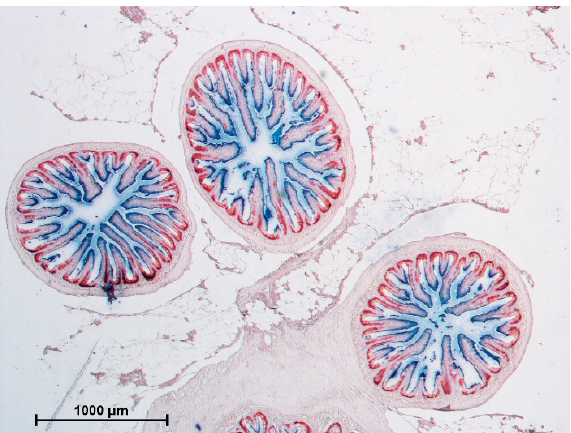
Figure 15. Representative figure of PCNA combined AP stained section pf pyloric caeca showing a proliferating pattern similar to that observed in the distal intestine and in the basal part of the complex folds.